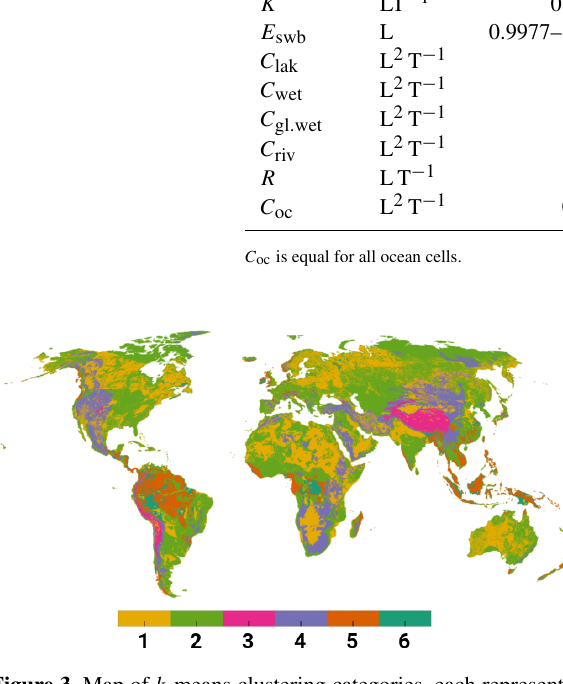
Figure 3. Map of k -means clustering categories, each representing a GHRU. Each color identifies a region where the combination of all three parameters is